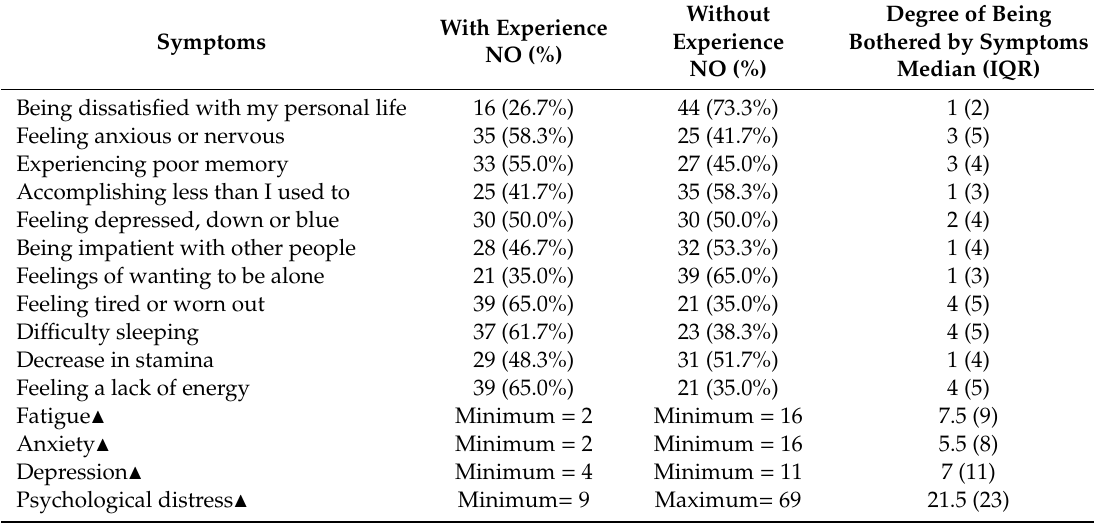
Table 1. Prevalence of psychological symptoms among the study